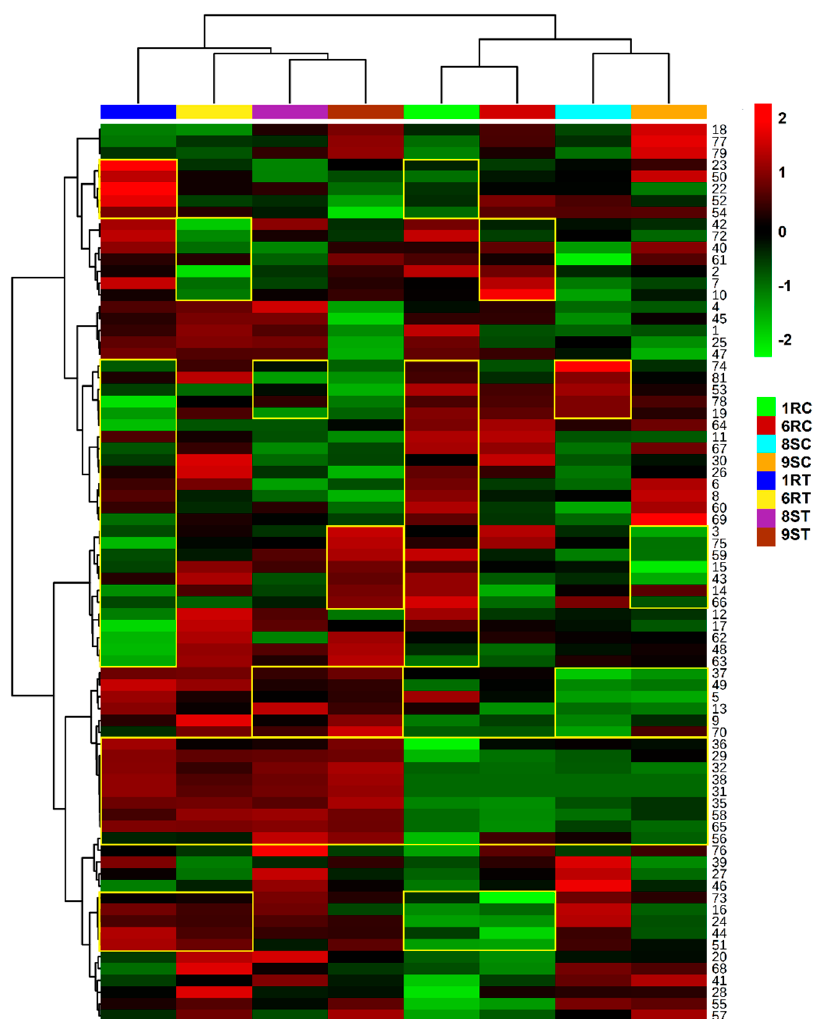
Figure 4. A heatmap analysis (Pearson distance and Ward’s linkage rule applied) showing the individual peak intensities of the 84 differential metabolite ions identified in the leaf tissue of the four tomato ( Solanum lycopersicum ) control cultivars compared with that of the R. solanacearum treated. The plants were incubated for 15 d to allow infection to be established. The heatmap indicates the mean peak intensity of each annotated metabolite following normalization and Pareto scaling of the data. The color scheme is noted in the legend above, indicating fold change increases (red), decreases (green) and significant changes between cultivar conditions (yellow borders). Each row represents a discriminant metabolite feature provided in Table S2, and numbered accordingly. The first four columns show the treated/infected tomato cultivars and the last four indicate the control cultivars.